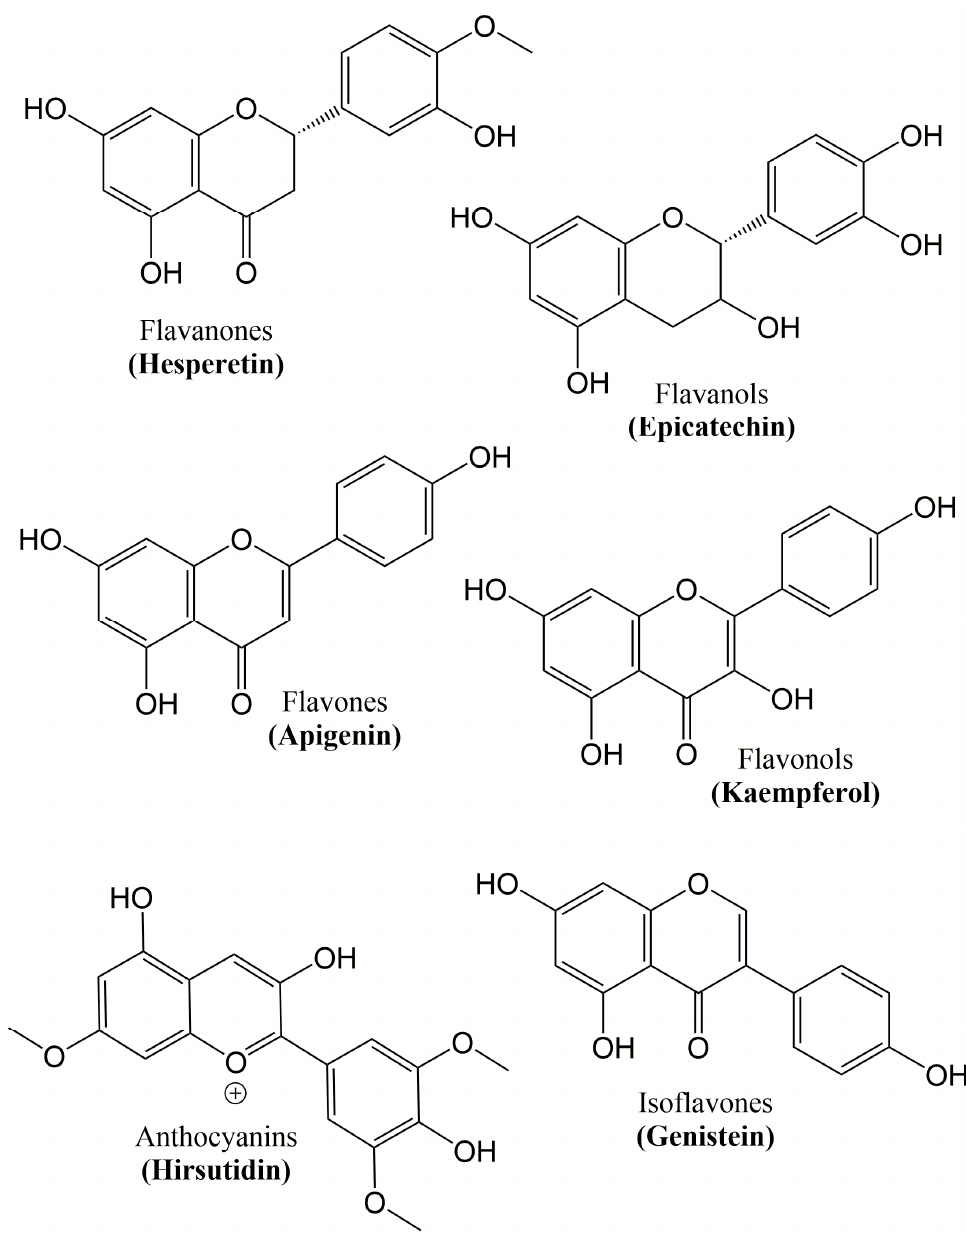
Figure 3. Chemical structure of the major classes of flavonoids.